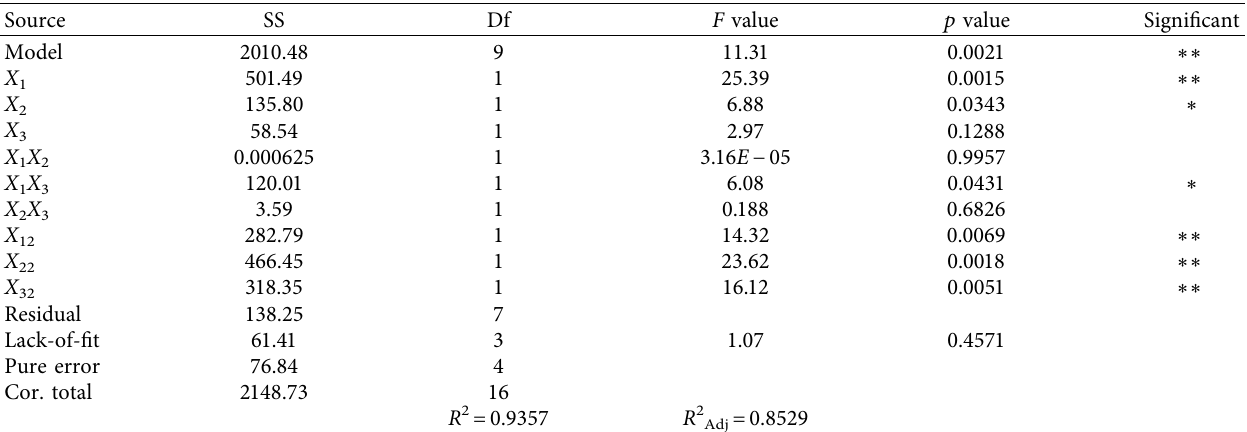
Table 6: ANOVA study for the model